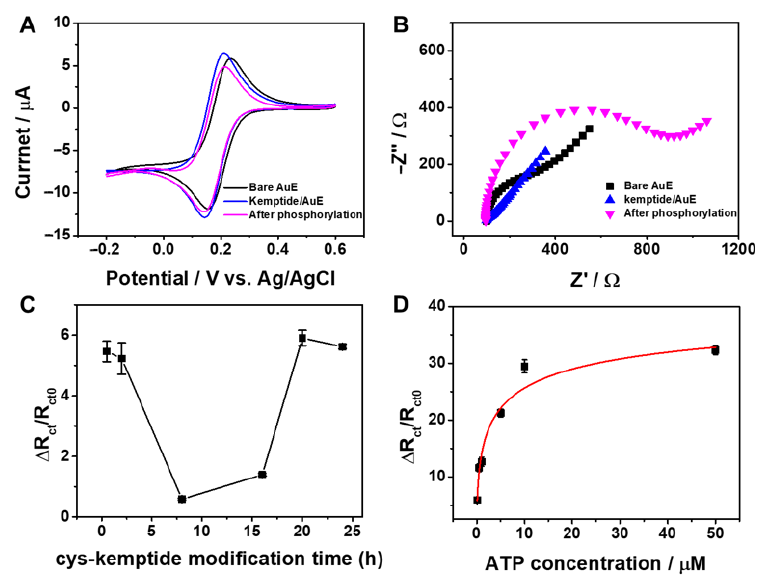
Figure 1. ( A ) CV and ( B ) EIS responses of bare Au electrode and kemptide/AuE before and after phosphorylation by 100 U/mL PKA in 0.01 M phosphate-buffered saline (PBS) solution (pH 7.4) containing 10 μM adenosine 5′-triphosphate (ATP) and 2 mM K 3 Fe(CN) 6 redox probe. ( C ) The effect of cys-kemptide modification time (0.5, 2, 8, 16, 20, 24 h) on the change in the electrochemical responses before and after the phosphorylation by 100 U/mL PKA in 0.01 M PBS solution (pH 7.4) containing 10 μM ATP and 2 mM K 3 Fe(CN) 6 . ( D ) The effect of ATP concentration (0.1, 0.5, 1, 5, 10, 50 μM) on the change in the electrochemical responses before and after the phosphorylation by 100 U/mL PKA in 0.01 M PBS solution (pH 7.4) containing 2 mM K 3 Fe(CN) 6 . Each experiment was per- formed in triplicate.